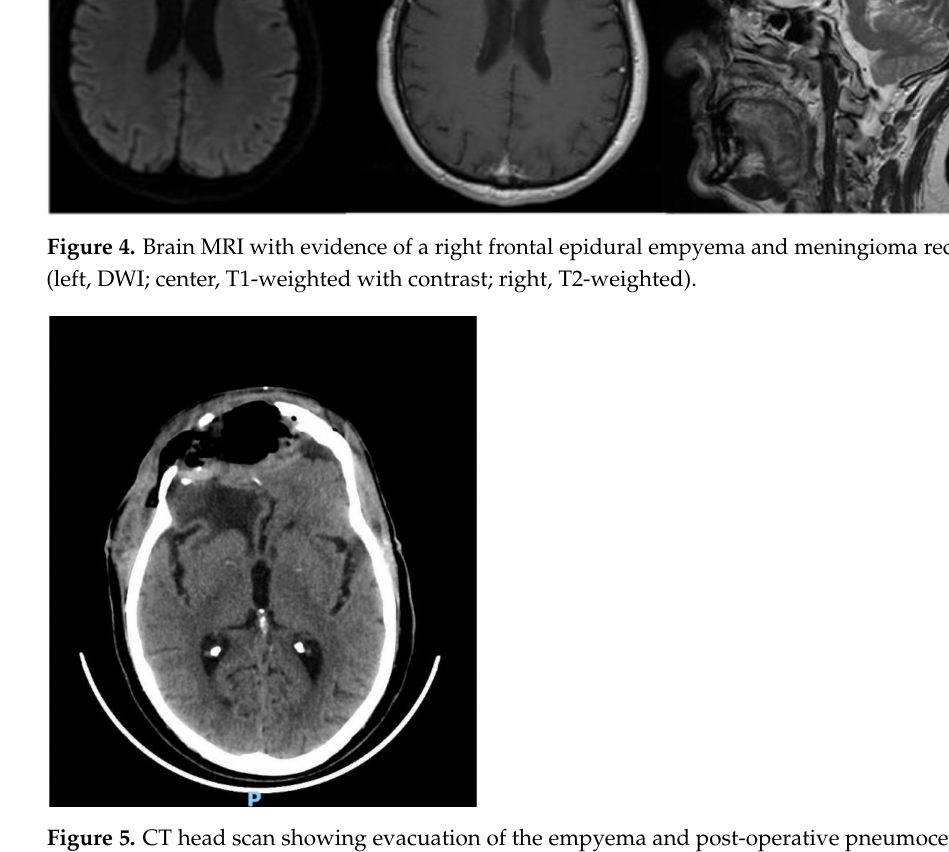
Figure 5. CT head scan showing evacuation of the empyema and post-operative pneumocephalus.